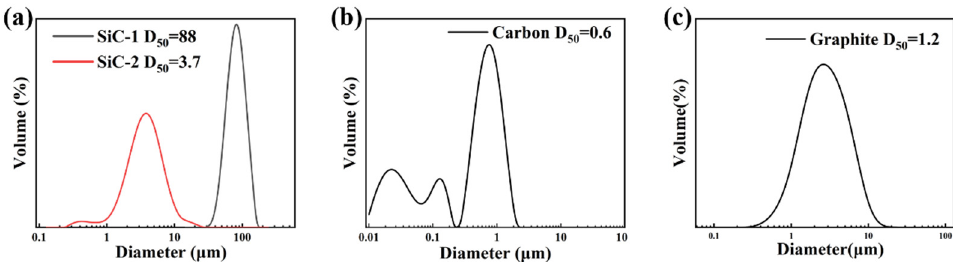
Figure 1. Particle size distribution diagram of the raw material. ( a ) SiC-1 and SiC-2; ( b ) carbon black; ( c ) graphite.